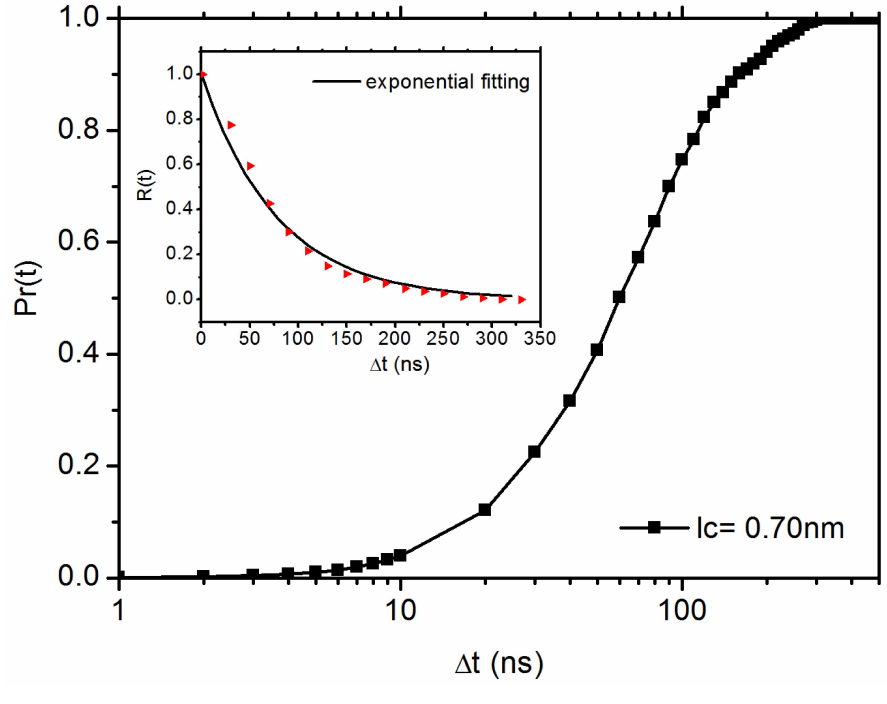
Figure 11. The probability ( Pr (t)) for the C 60 NP to escape from the cage with a radius lc = 0.7 nm. The inset shows the probability for the C 60 NP to be maintained in the cage R (t) = 1 − Pr (t).